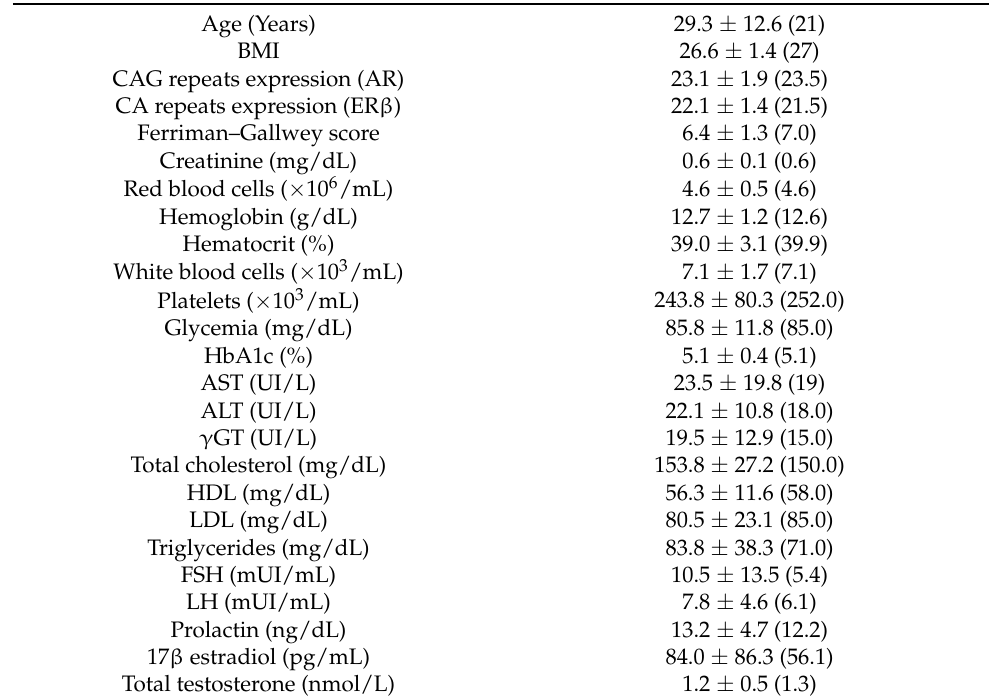
Table 2. Baseline characteristics of the enrolled AMAB subjects. Continuous data are shown as the mean ± standard deviations and the median (in brackets).